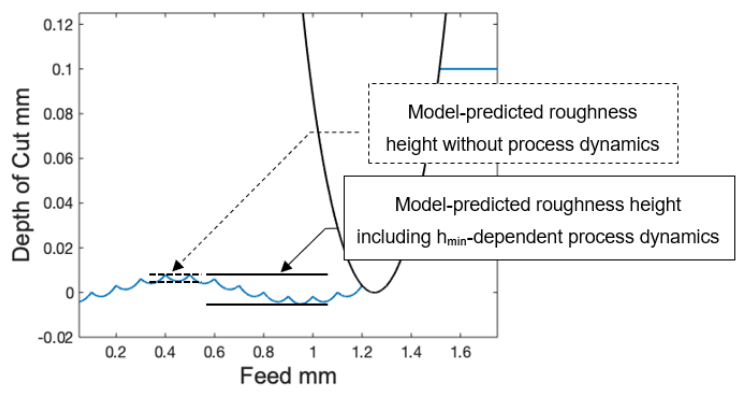
Figure 11. Surface profile altered by MTE (MTE), typical of way axis-induced error.